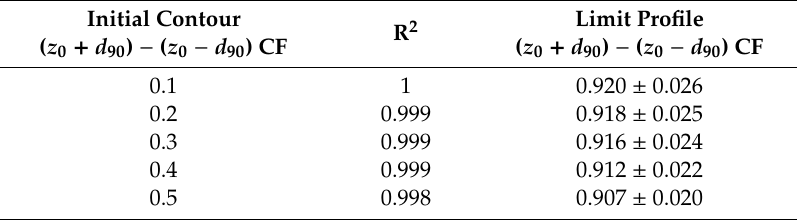
Table 5. Relationship between initial contour cumulative frequency and limit contour